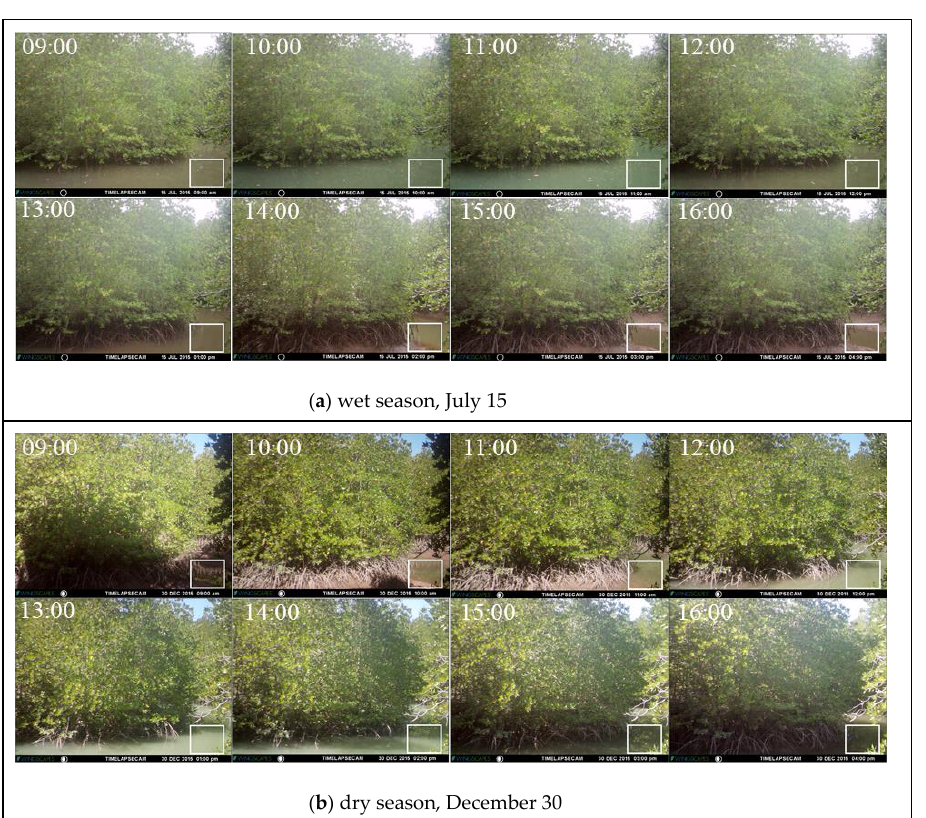
Figure 4. Diurnal hourly time lapse sequence of phenocam-2 images in the ( a ) wet season (July 15) and ( b ) dry season (December 30), displaying tidal cycles of changing water level and water color, as well as changing illumination conditions from backscatter (morning) to forward scatter (afternoon) solar angles and differences between diffuse radiation (wet season) and global radiation (dry season).